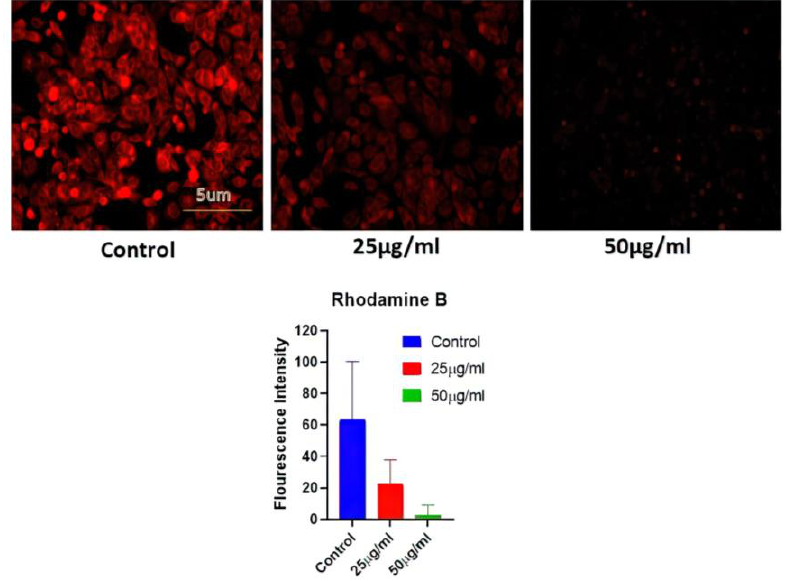
Figure 6. Determination of mitochondrial potential reduction after variable BAgNPs treatment in cancer cell lines by fluorescence microscopic analysis. Untreated cells were used as a control.